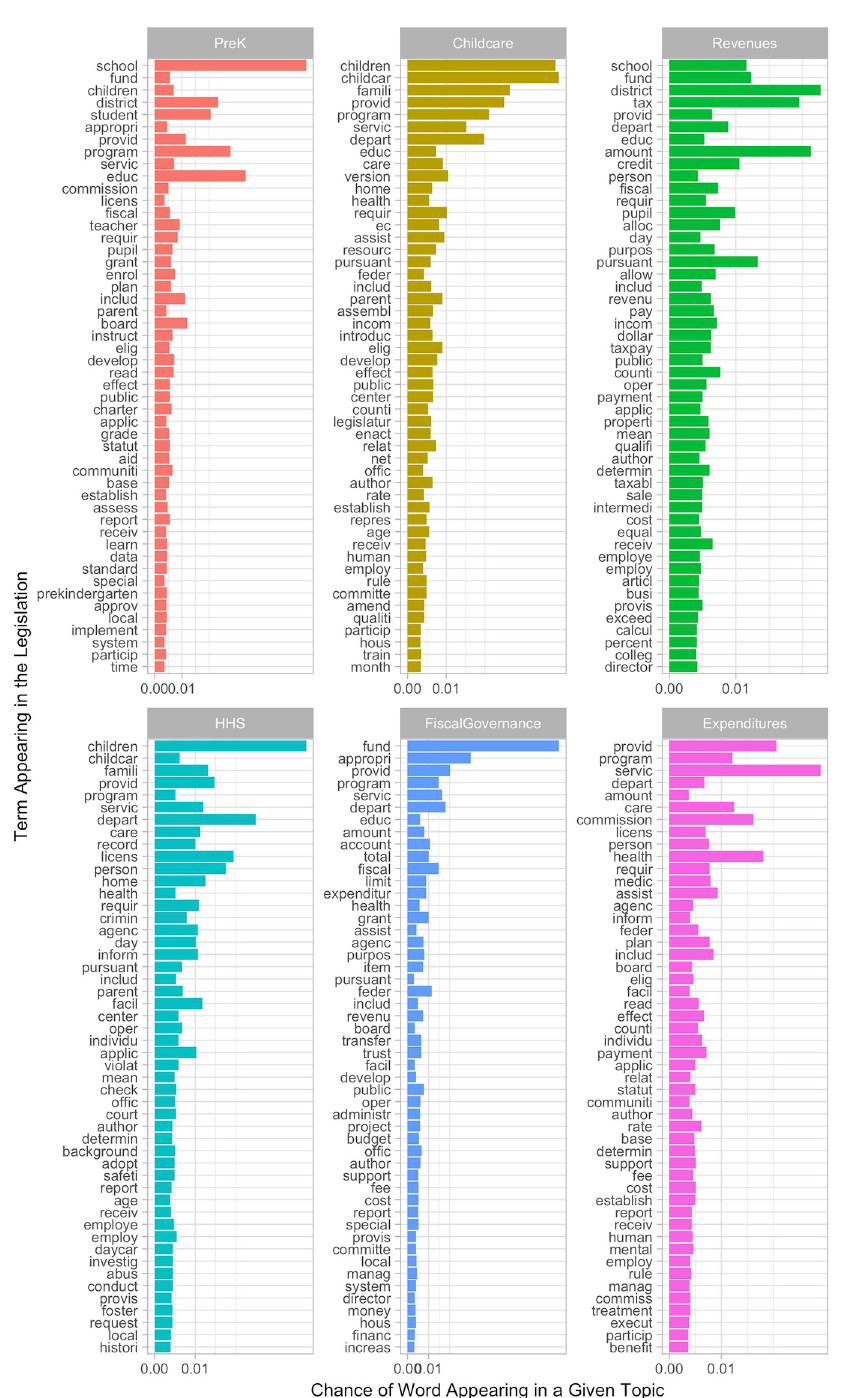
Fig 5. Six topics discovered through LDA with 50 highest frequency